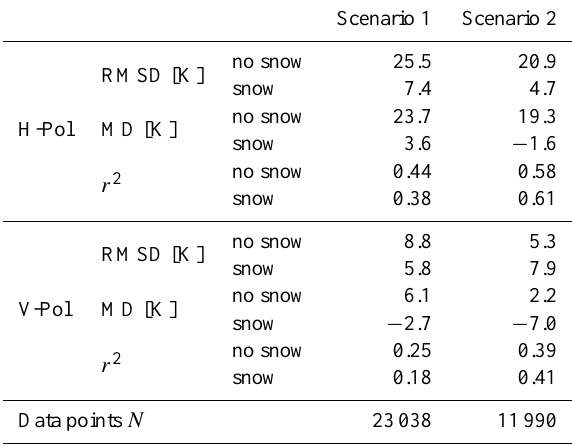
Table 2. Root mean square deviations RMSD, mean deviations MD, and coefficients of determination r 2 for simulated brightness tem- peratures and brightness temperatures as measured by SMOS for horizontal and vertical